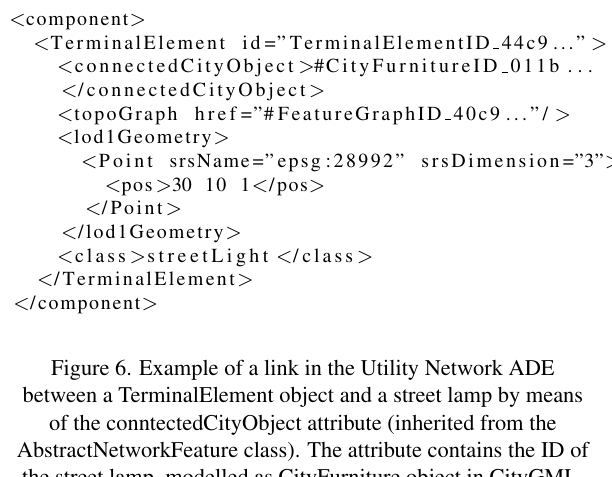
Figure 6. Example of a link in the Utility Network ADE between a TerminalElement object and a street lamp by means of the conntectedCityObject attribute (inherited from the